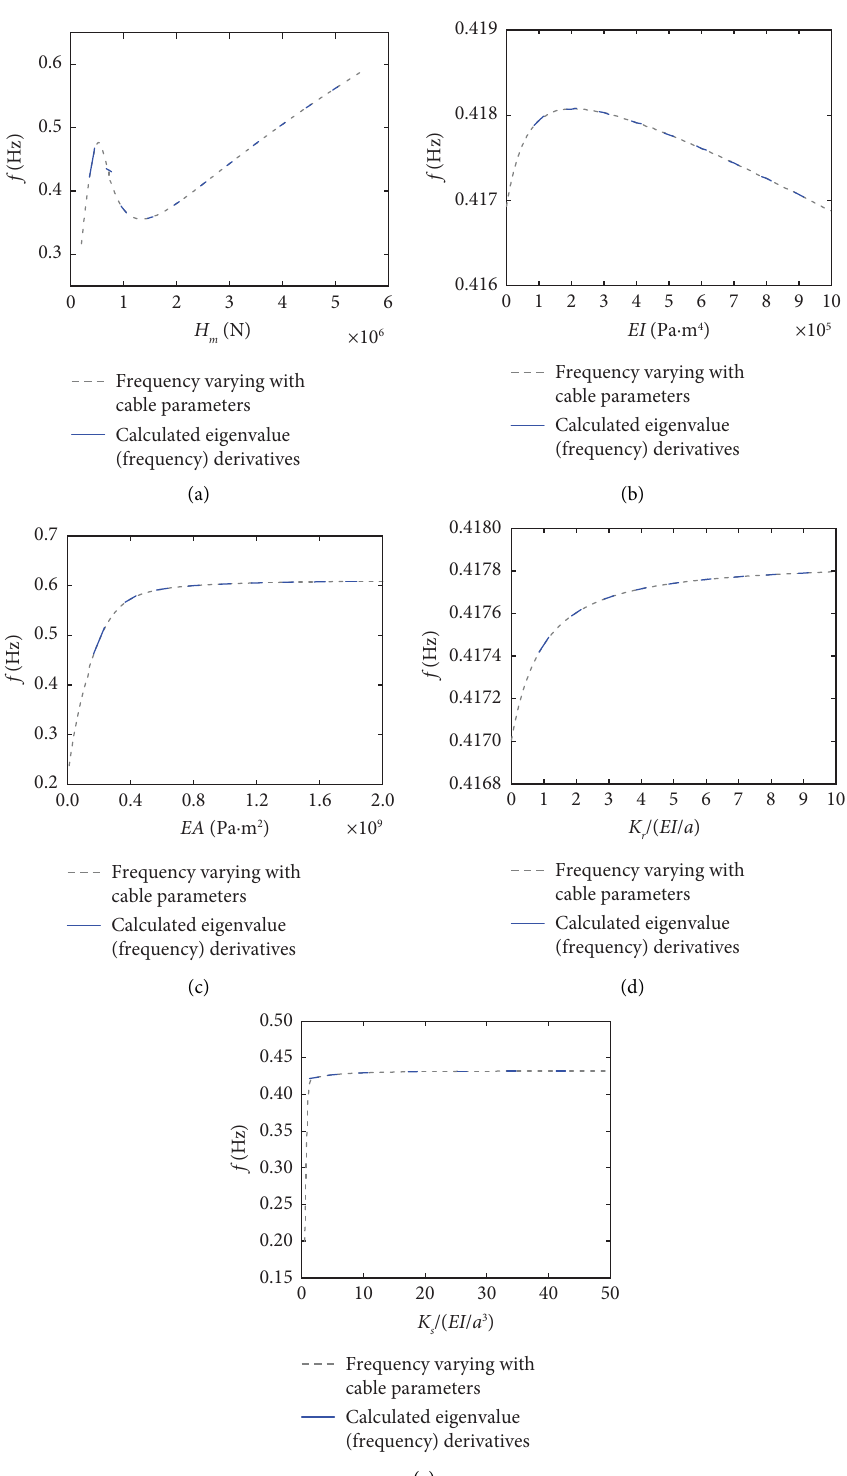
Figure 8: Illustration of calculated derivatives of the frst eigenvalue (frequency) of cable 2 with respect to its system parameters: (a) H (b) EI; (c) EA; (d) K r ; and (e) K s